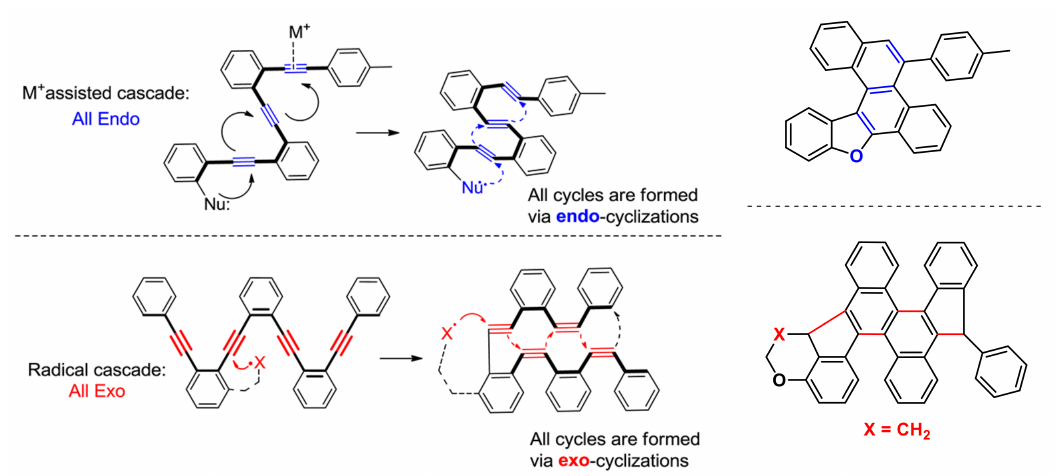
Figure 35. Examples of polyaromatic self-assembling based on the cascade oligocyclization of alkynes (reproduced with permission from [341]. Copyright 2012 American Chemical